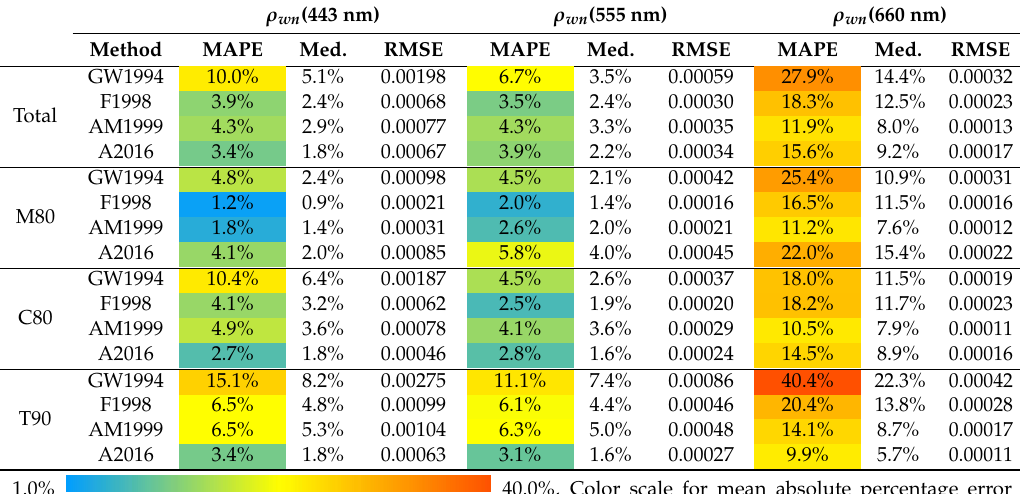
Figure 2. Water reflectance ( ρ wn ) retrieval accuracy of the ( a ) blue; ( b ) green; and ( c ) red bands in the atmospheric correction algorithm after integrating the four aerosol correction schemes. Chlorophyll- a estimation error based on OC3 [33] is plotted in ( d ). Table 4. Statistical summary of atmospheric correction accuracy.